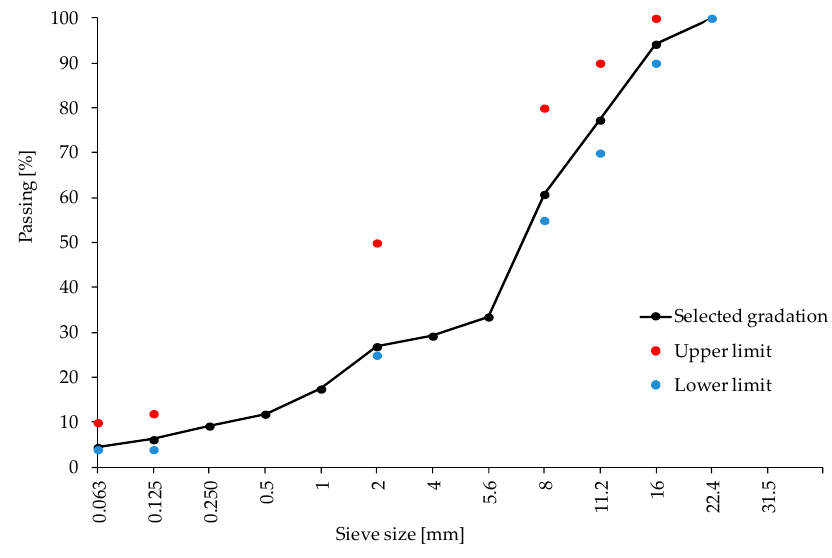
Figure 1. Aggregate gradation of the reference asphalt mix.